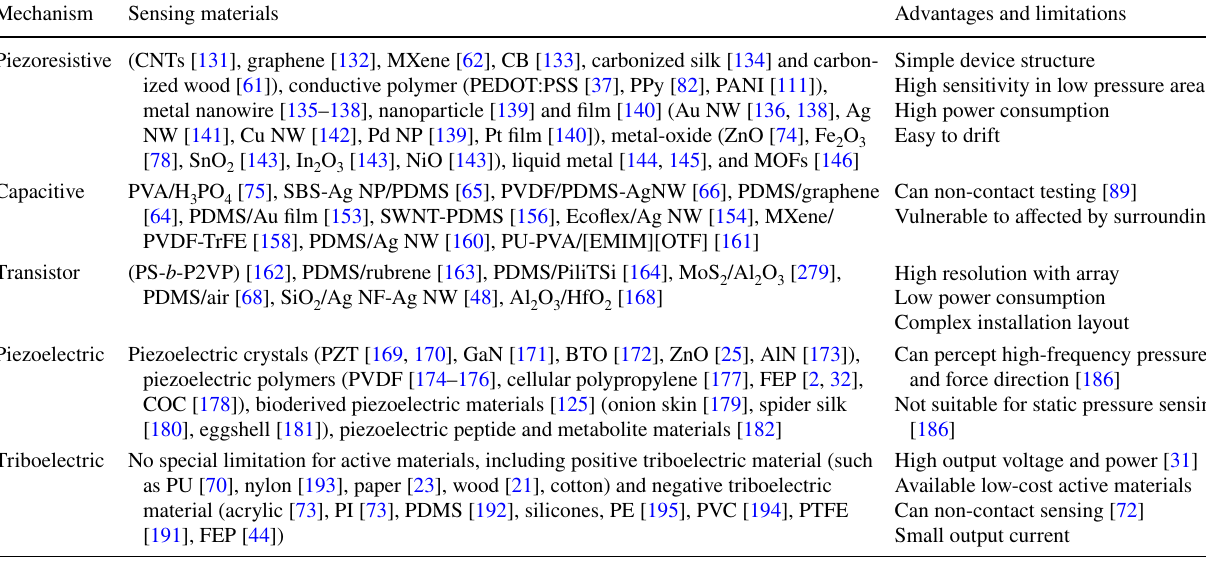
Table 1 Summary of sensing materials, uniqueness and limitations for pressure sensors